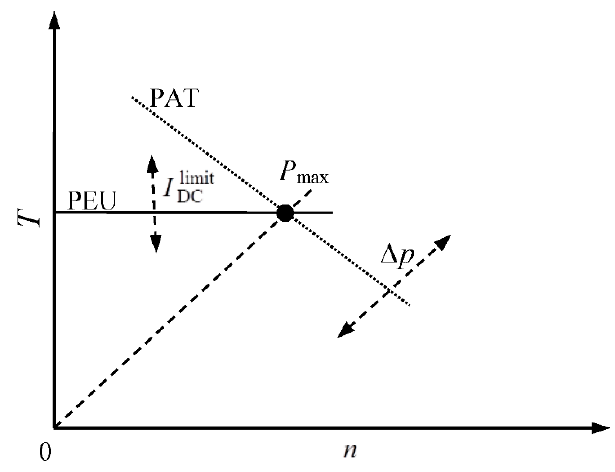
Figure 6. PAT curves showing characteristics of: ( a ) power P t ( n ) ; and ( b ) torque T t ( n ) for different values of reduced pressure ∆ p .